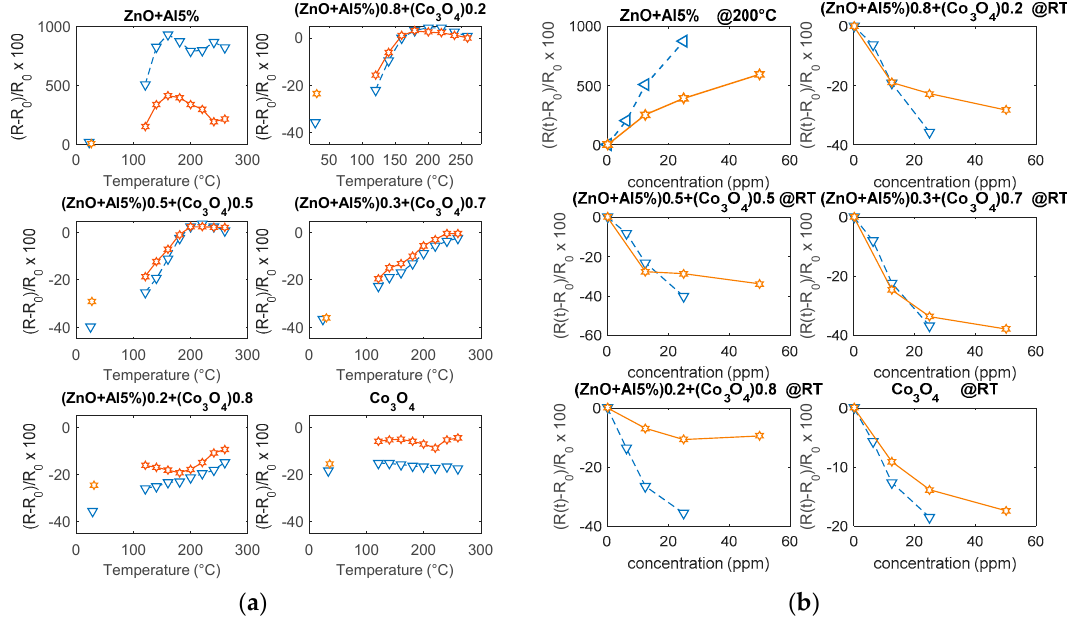
Figure 10. ( a ) Response to 25 ppm of NO 2 as a function of temperature. Marker triangles—humid environment (RH = 50%). Marker stars—dry environment. ( b ) Sensor response vs. NO 2 concentration at 200 °C (ZnO-Al5%) and room temperature (RT) (the other materials).